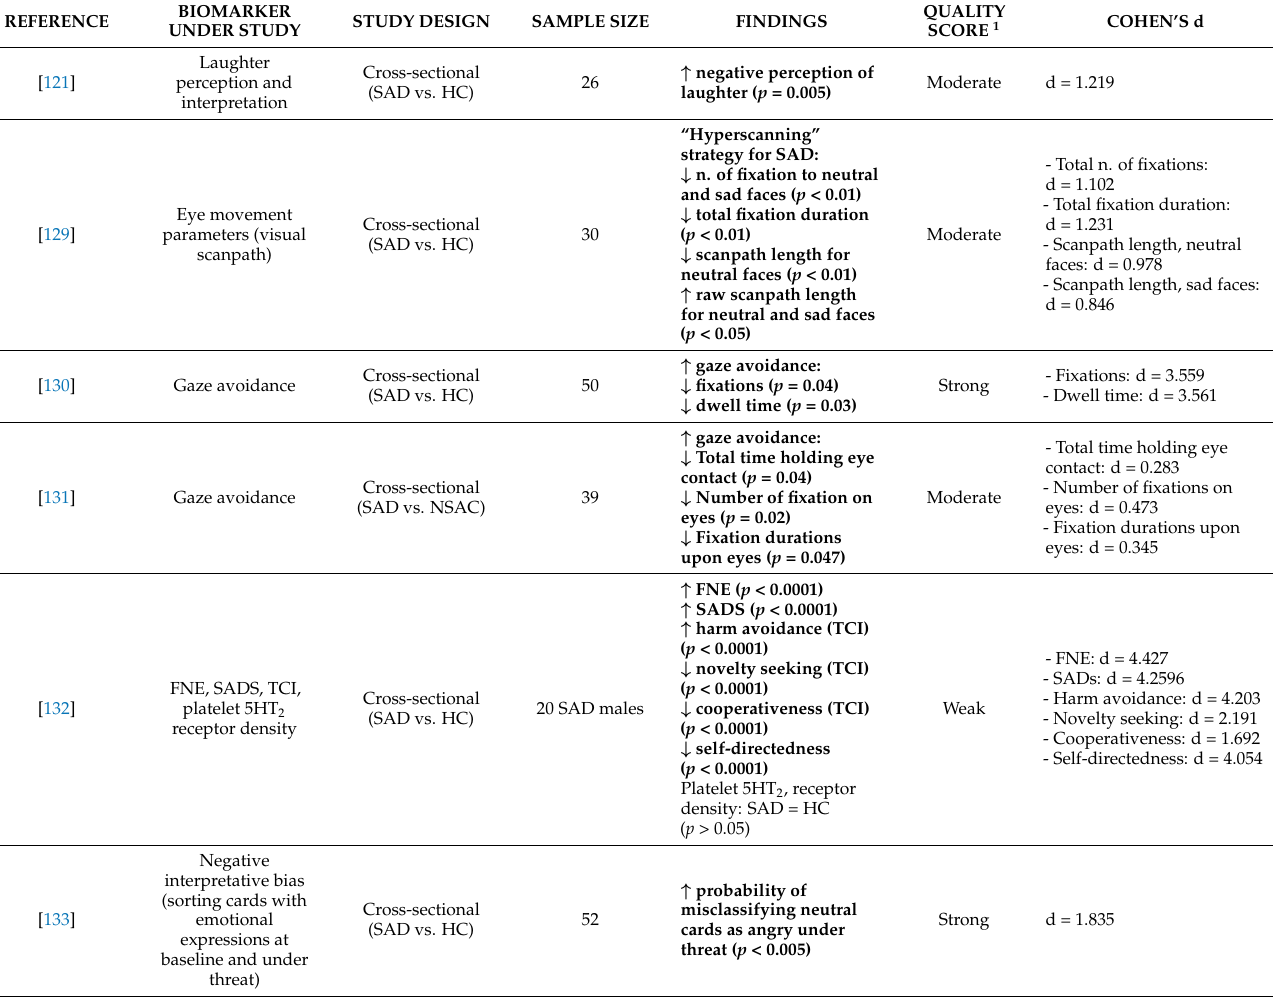
Table 7. Summary of findings regarding neuropsychological biomarkers of